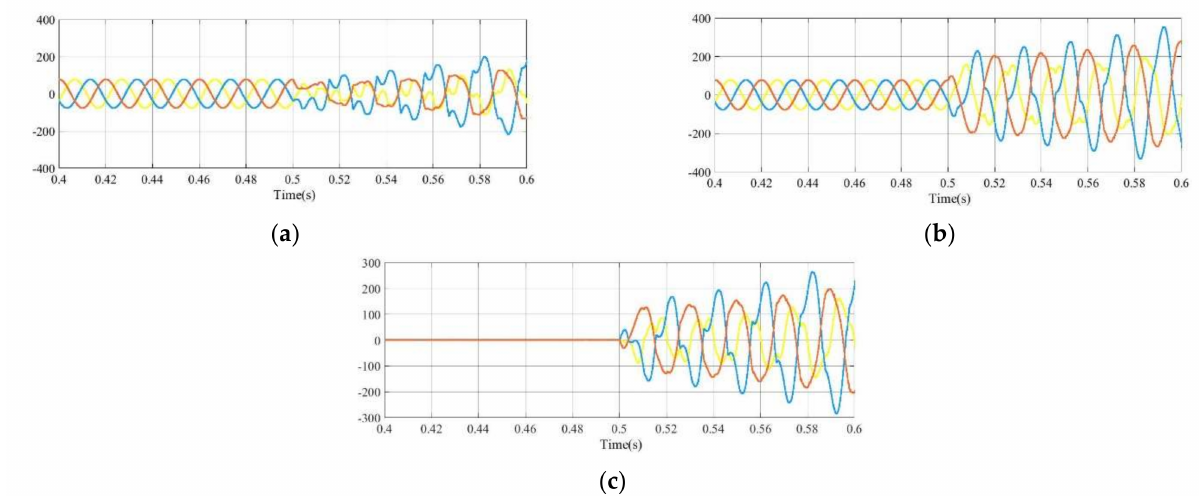
Figure 13. Simulation results without reconfigured structure and pulse-resetting. ( a ) The output currents of inverter 1; ( b ) The output currents of inverter 2; ( c ) The circulating currents between inverter 1 and inverter